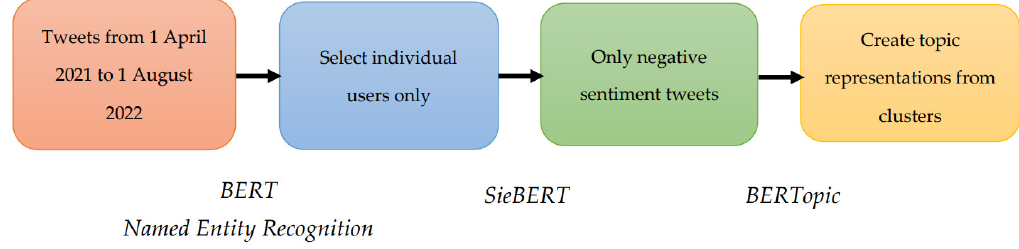
Figure 1. Unsupervised machine learning of free-text data from Twitter using BERT.